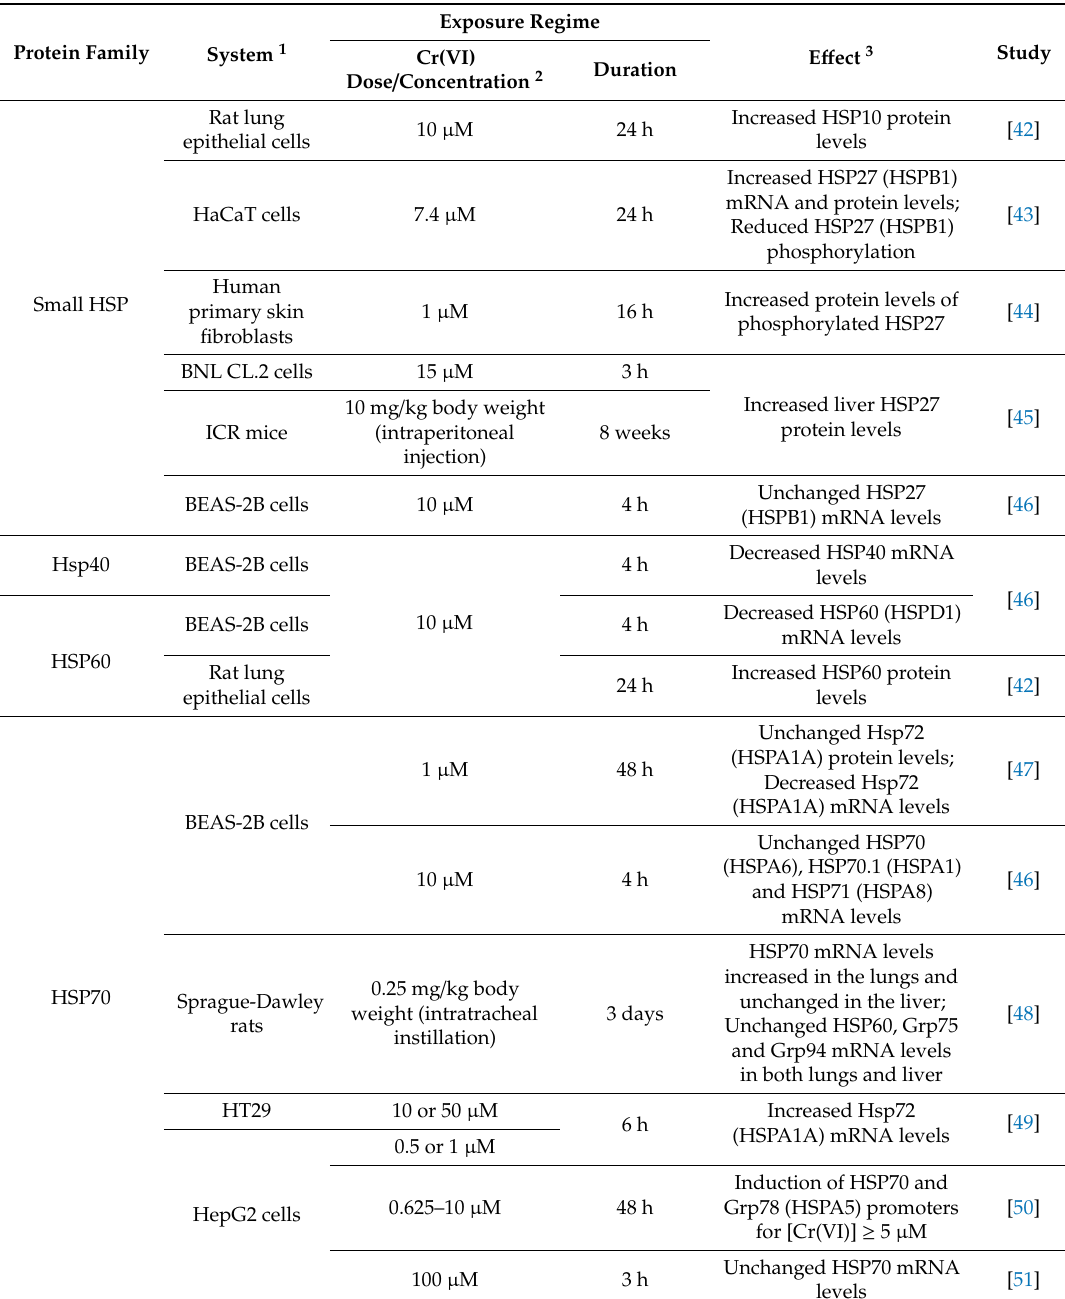
Table 1. Cr(VI)-induced e ff ects on the expression and activity of components of the stress response.